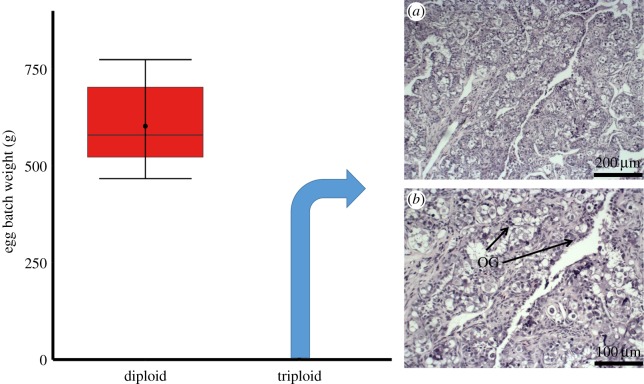
Stripped egg batch weight from female diploid Atlantic salmon (n = 10) and histochemical analysis of ovaries at (a) 100× and (b) 200× magnification from 3-year-old triploid salmon, showing oogonia (OG), but no evidence of mature oocytes in triploid female ovaries (n = 10). Boxplots show median (horizontal black line) and mean (thick black dot); whiskers indicate points within the 1.5 IQR and quartile ranges (coloured box area).